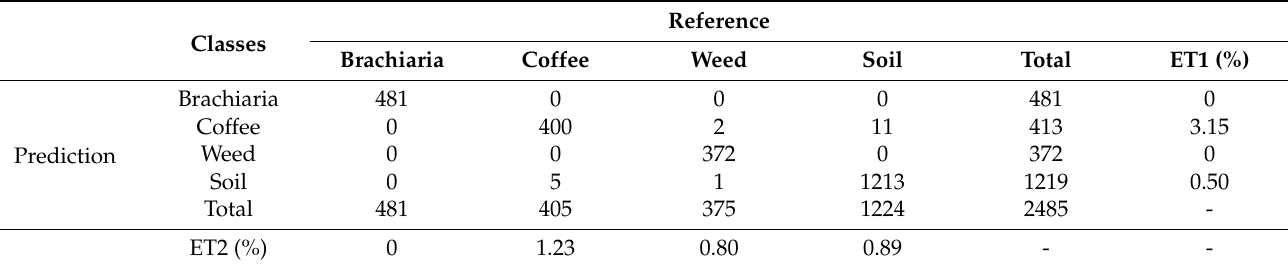
Table 2. Confusion matrix for the RF machine learning algorithm.